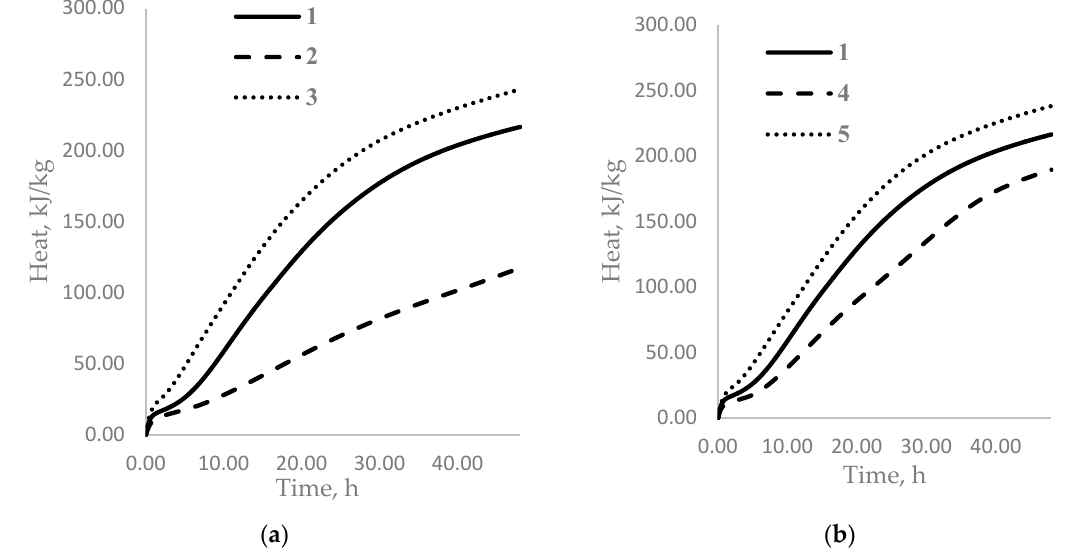
Figure 5. Heat curves for mixtures of cement with 5% sodium and potassium water glasses. 1—100% CEM; 2—100% CEM + 5% SWG into the mixing water; 3—100% CEM + 5% SWG into the water and cement mixture; 4—100% CEM + 5% PWG into the mixing water; 5—100% CEM + 5% PWG into the water and cement mixture. ( a ) CEM + sodium WG; ( b ) CEM + potassium WG.